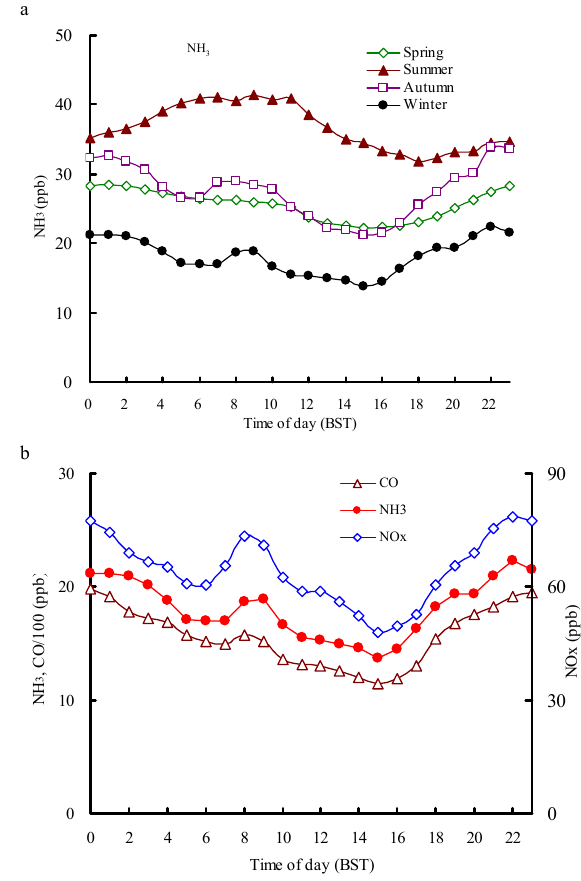
Fig. 9. Averaged diurnal variations of NH 3 at CMA in four seasons from June 2009 to May 2010 (a), and NOx and CO in winter 2009 (b).